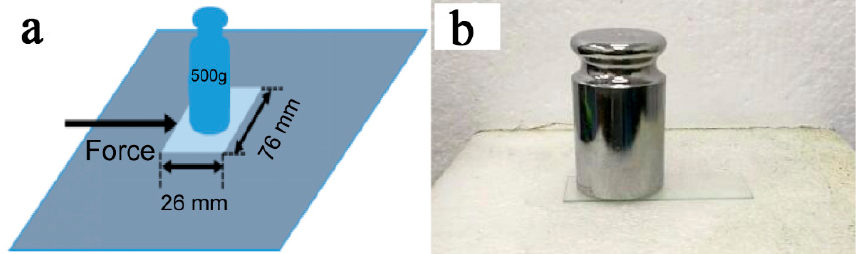
Figure 12. The EP-POSS friction test method.